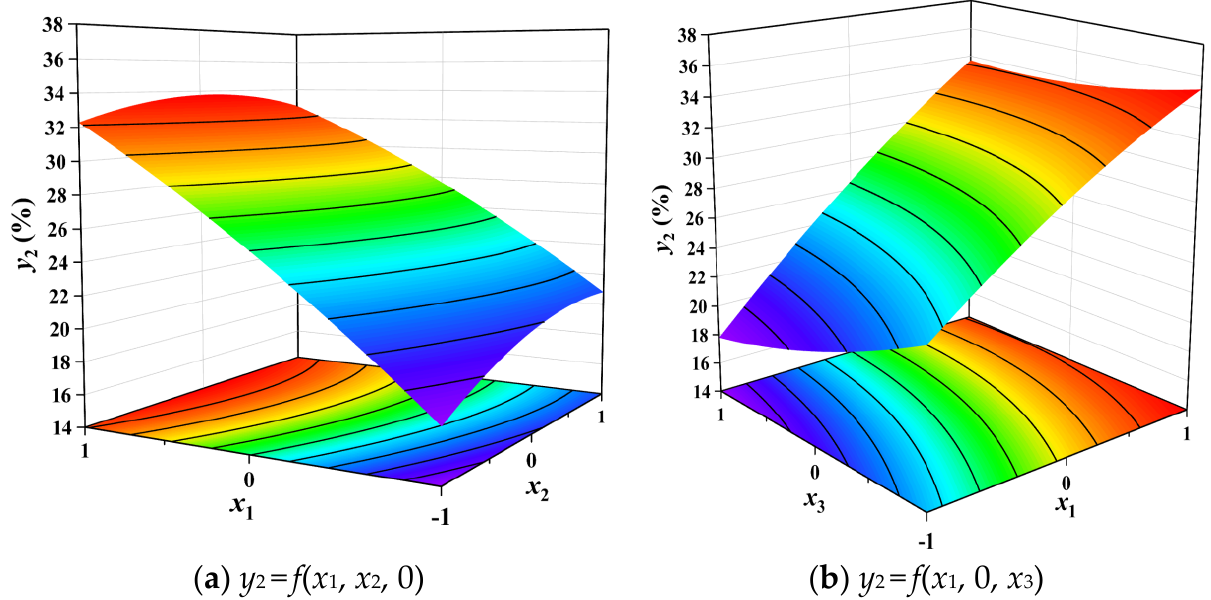
Figure 12. Effect of interaction between factors on CV.